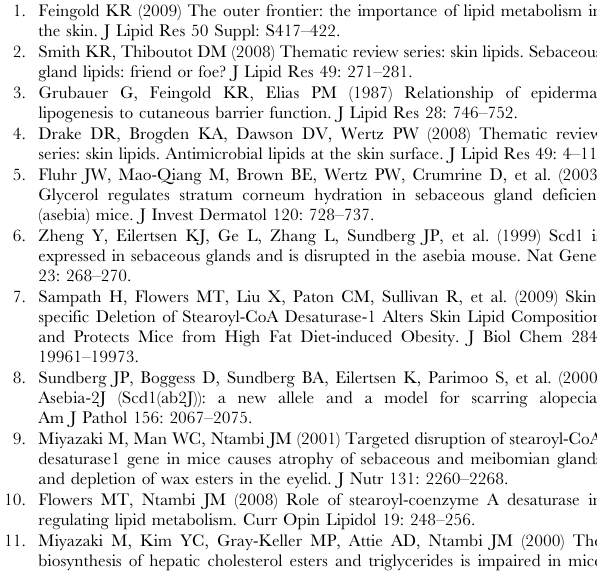
Table S3 Proteases and peptidases. Changes in gene expression are reported as fold-change (FC) relative to Lox mice. Significant differences between Lox and SKO were determined as described in Methods , and for both Welch’s t-test and EBarrays the false discovery rate was set at 5%. All probe sets listed have a posterior probability of differential expression (PP of DE) . 0.639 (soft threshold) based upon analysis by EBarrays. Additionally, Welch’s t-test was used to calculate q-values and those probe sets with q-values , 0.05 were considered significant. Table S4 Collagens, keratins, gap junctions and tight junctions. Changes in gene expression are reported as fold- change (FC) relative to Lox mice. Significant differences between Lox and SKO were determined as described in Methods , and for both Welch’s t-test and EBarrays the false discovery rate was set at 5%. All probe sets listed have a posterior probability of differential expression (PP of DE) . 0.639 (soft threshold) based upon analysis by EBarrays. Additionally, Welch’s t-test was used to calculate q- values and those probe sets with q-values , 0.05 were considered